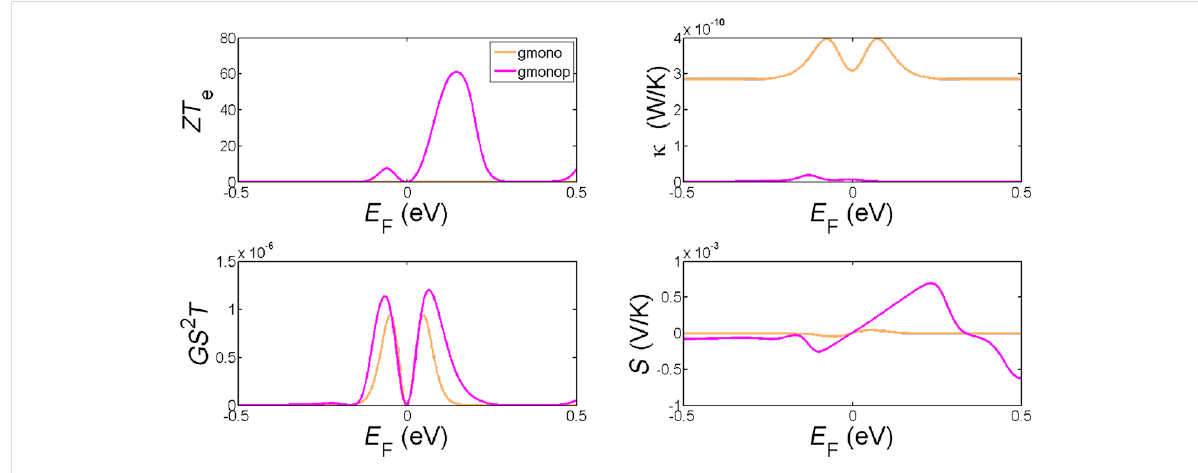
Figure 5: The variation of room-temperature values of ZT e , GS 2 T , S and κ as a function of the Fermi energy E F for a zigzag monolayer graphene ribbon (gmono) and a monolayer graphene nanopore (gmonop).